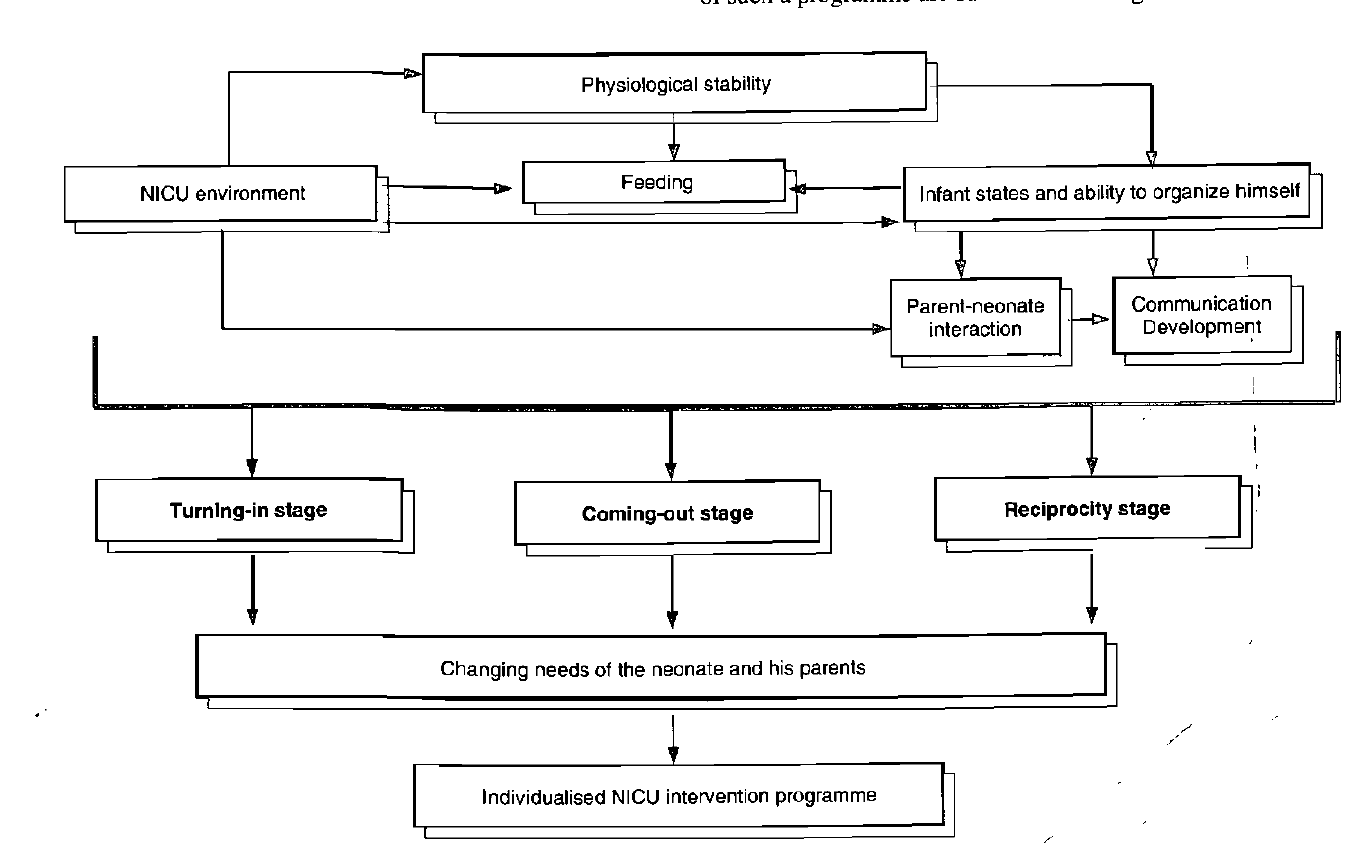
Figure 4. The interrelationship between the developmental areas and stages of the participant which may guide the NICU intervention programme Die Suid-Afrikaanse Tydskrif vir Kommunikasieafwykings, Vol. 52,